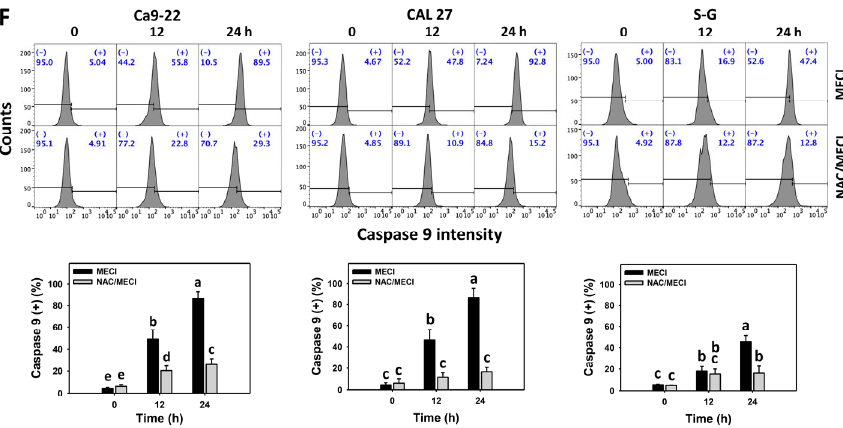
Figure 5. Cas 3/8/9 activation. ( A , C , E ) Cas 3/8/9 assay. Except for S-G cells, other cells were oral cancer cells. After 24 h MECI incubation (0 (0.1% DMSO in the medium), 10, and 30 µ g/mL), cells were applied to Cas 3/8/9 assays. (+) spots were specified for Cas 3/8/9 (+). ( B , D , F ) Impact of NAC on MECI-induced Cas 3/8/9 change to oral cancer cells. After pretreating with NAC, cells were post-treated with MECI (30 µ g/mL) for 0, 12, and 24 h. Data, mean ± SD ( n = 3). For the same cell line, columns showing non-overlapping letters differ significantly ( p < 0.05).